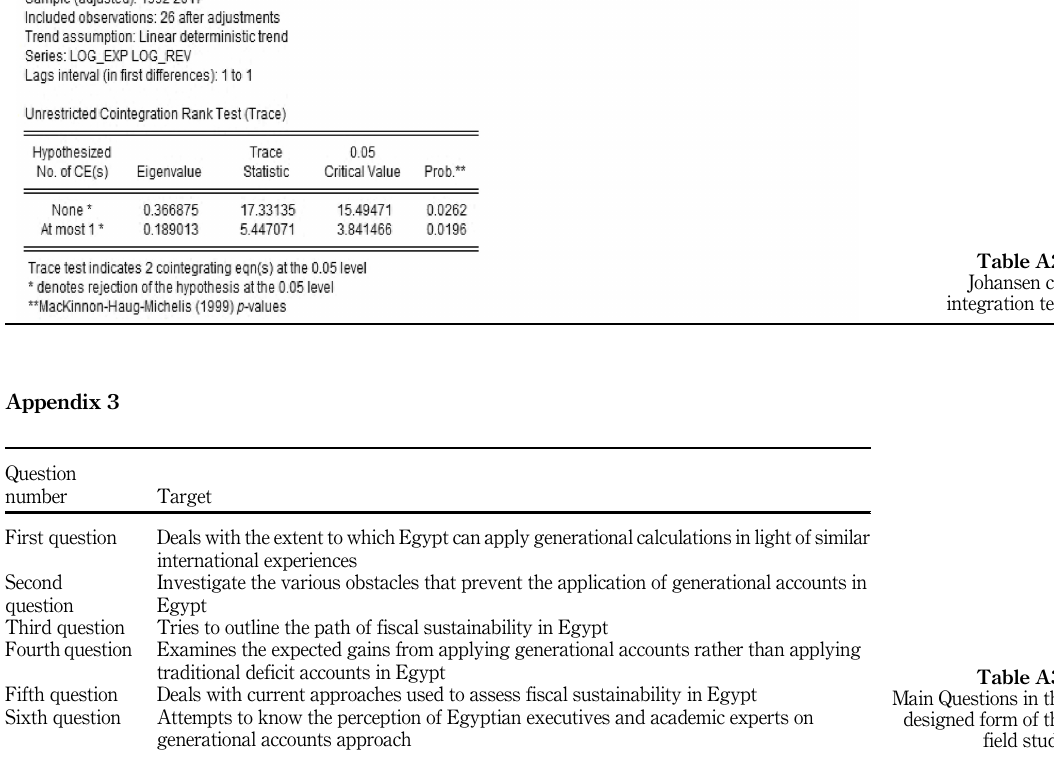
Table A3. Main Questions in